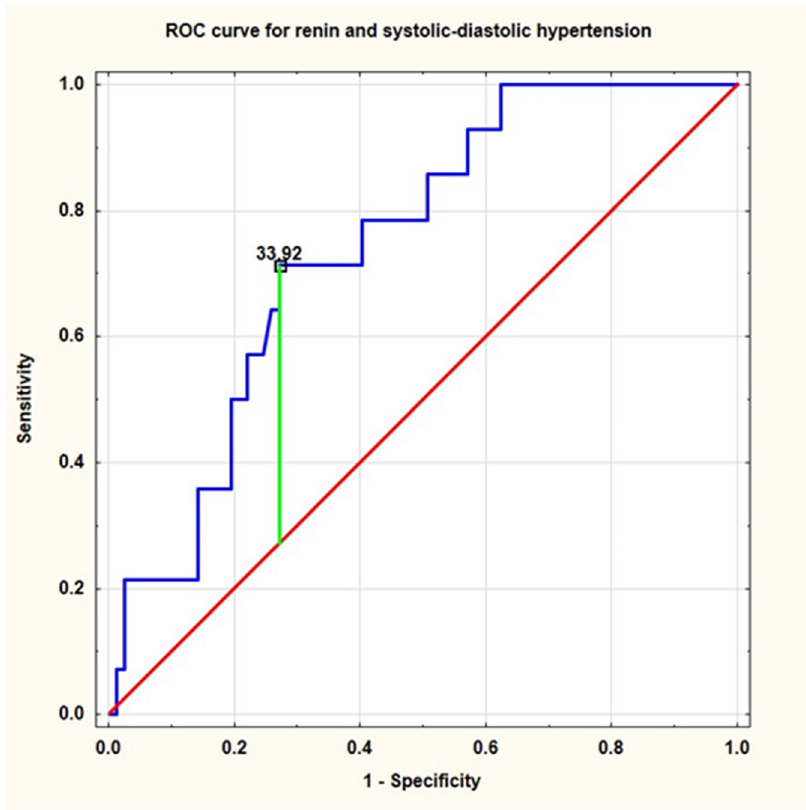
Figure 2. Receiver operating characteristic (ROC) curve for active renin concentration and the presence of primary hypertension (ROC—receiver operating characteristics).